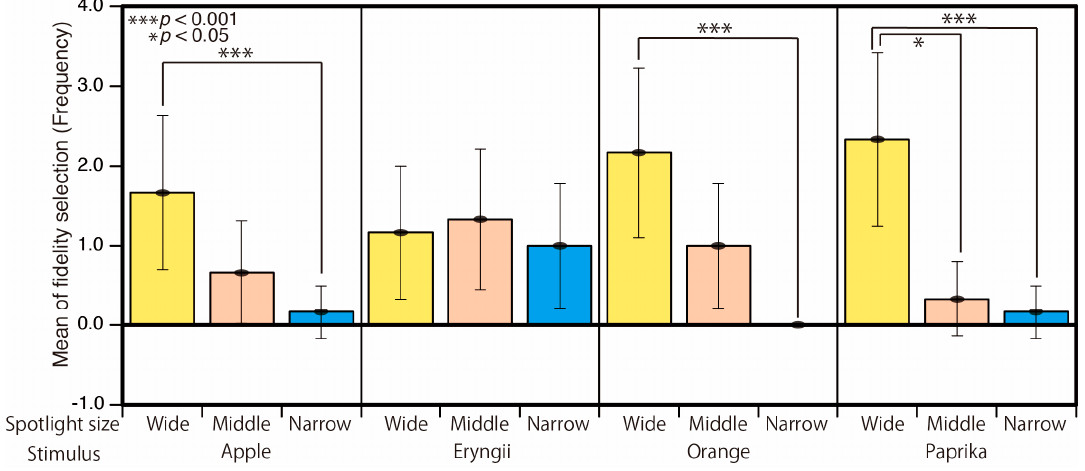
Figure 8. Result of fidelity selection for each stimulus.